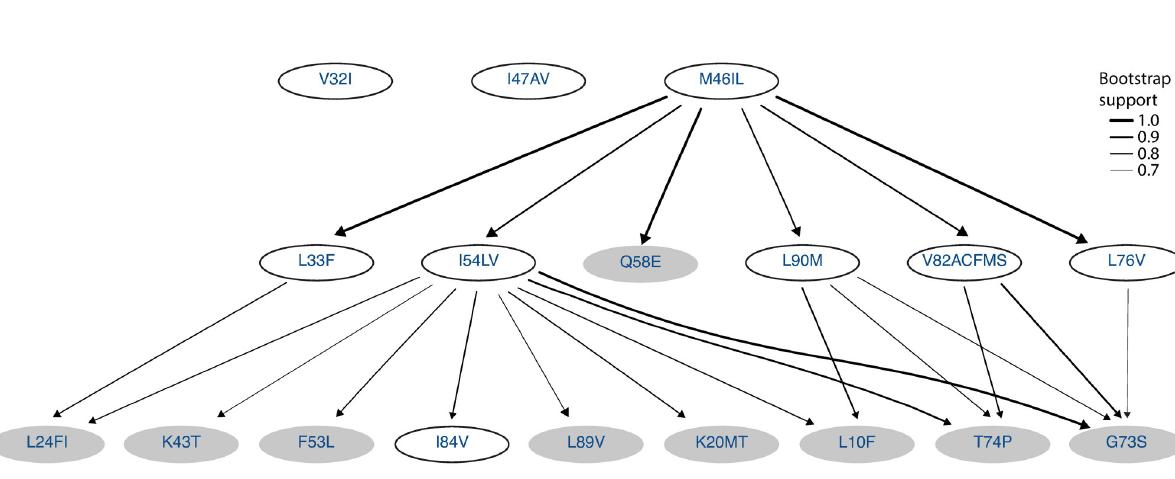
PLOS Computational Biology | https://doi.org/10.1371/journal.pcbi.1008363 September 7, 2021 15 /